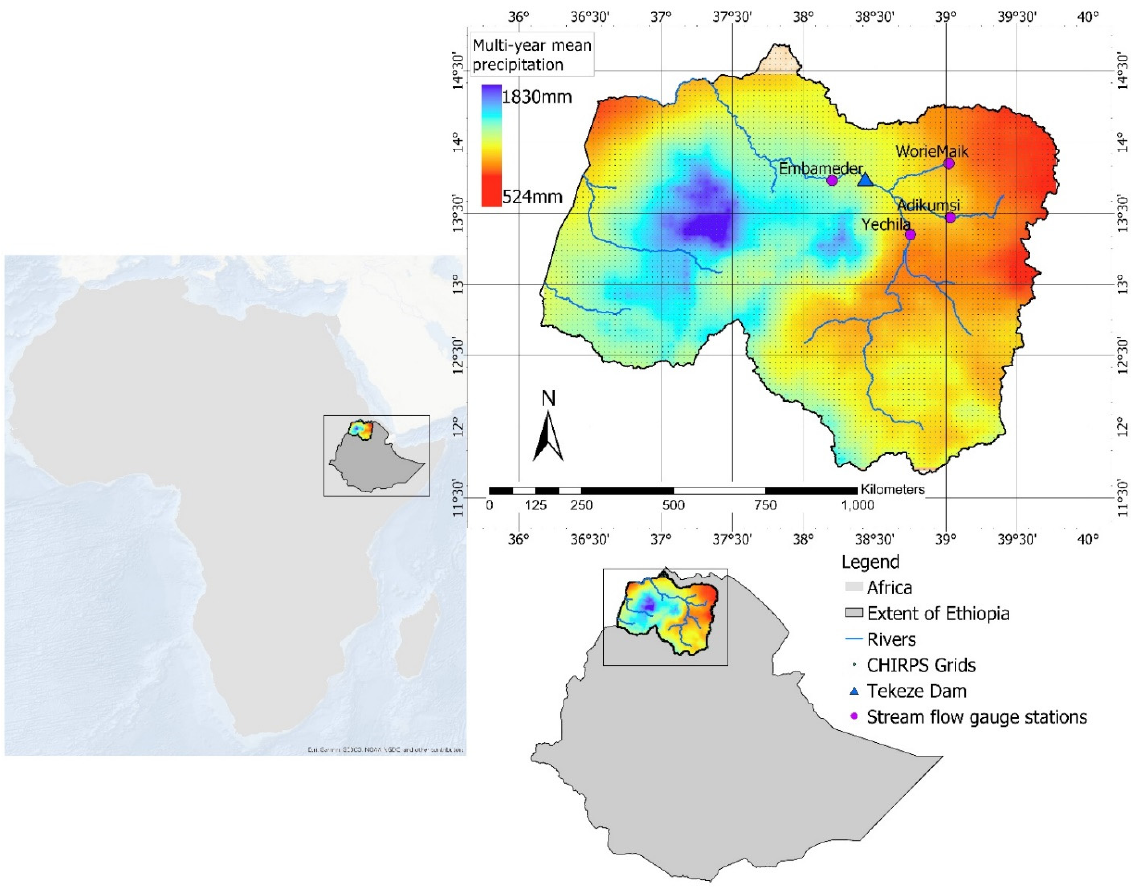
Figure 1. Location map of Tekeze River Basin relative to Ethiopia showing multi-year mean CHIRPS precipitation.